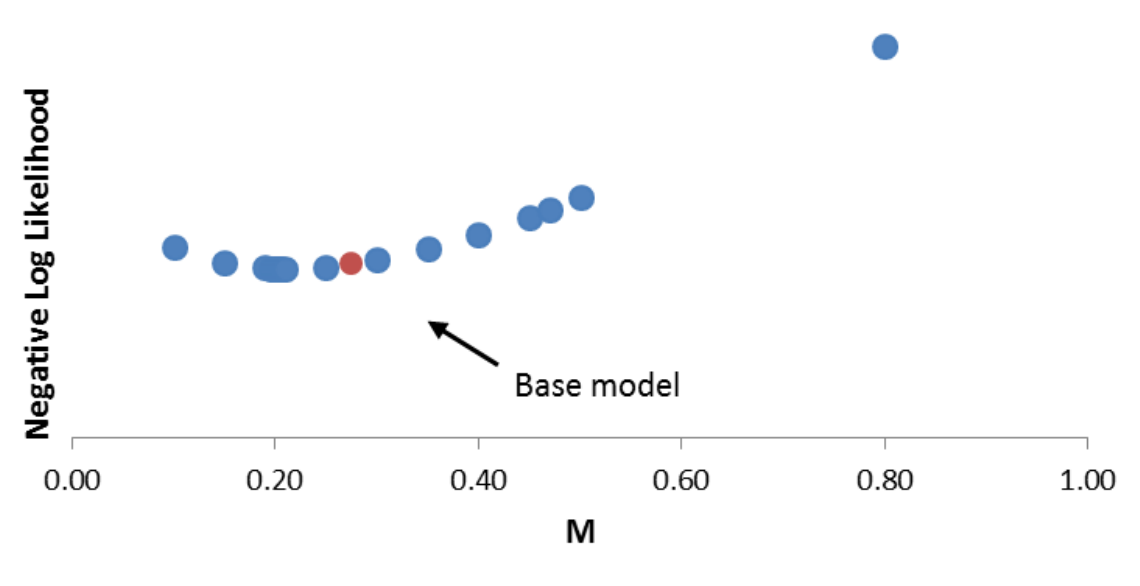
Figure 114. Likelihood profile of base CMSA model runs with varying M inputs. Y- axis values have been removed due to CONFIDENTIAL